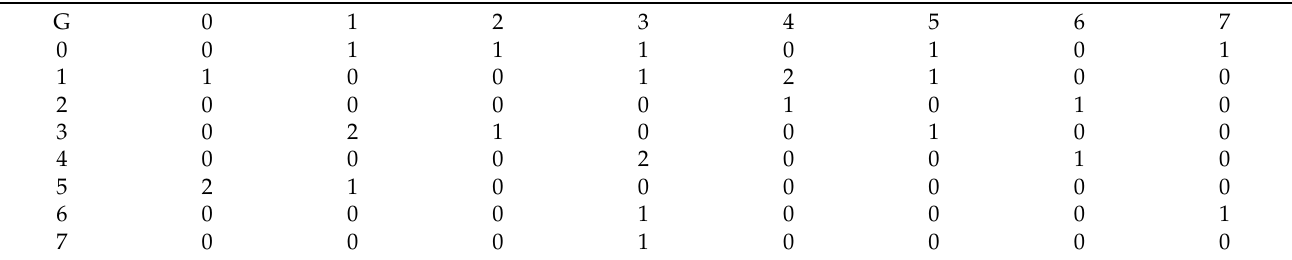
Table 3. GLCM matrix for feature